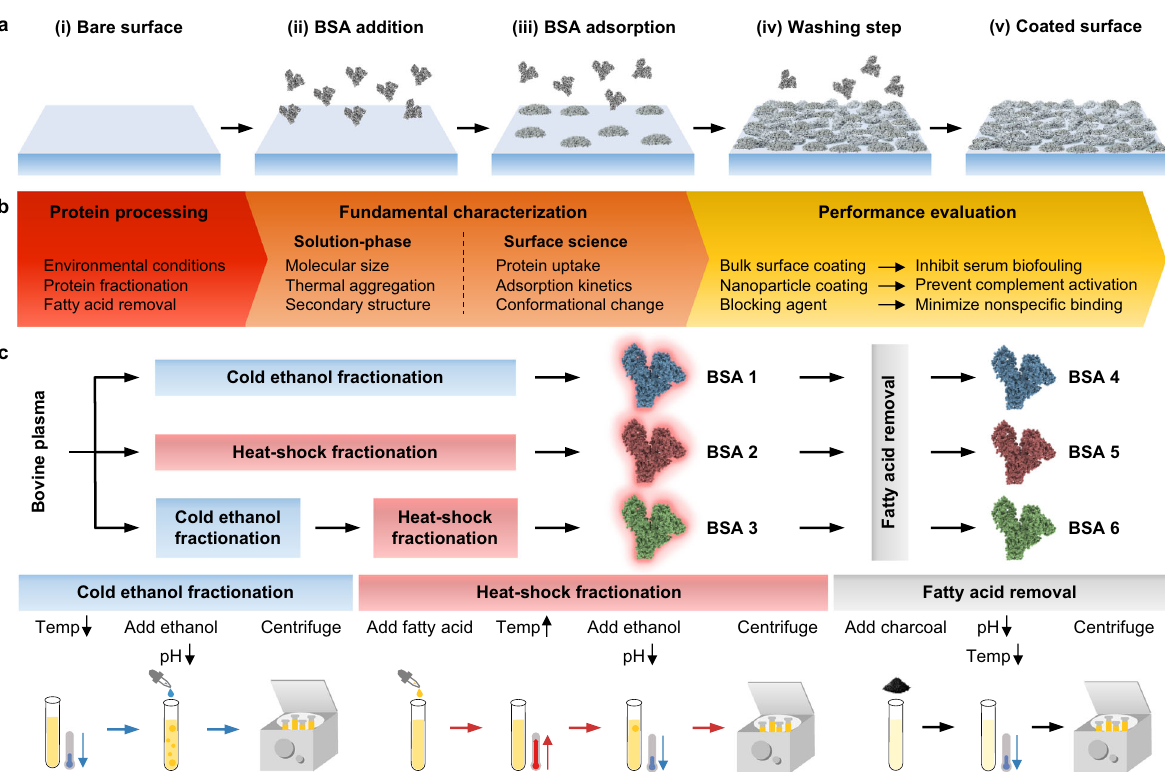
Fig. 1 Evaluation of BSA proteins to fabricate antifouling coatings. a Overview of basic steps in BSA coating protocols. (i) A target surface is identi fi ed to coat with BSA for surface passivation. (ii) BSA proteins in aqueous solution are incubated with the target surface. (iii) BSA proteins adsorb and denature on the target surface. (iv) A washing step is performed to remove weakly bound BSA protein molecules. (v) A fi rmly attached monolayer of adsorbed BSA protein molecules is formed on the surface. b Overall experimental strategy to analyze fabrication of BSA-based ultrathin fi lm coatings in terms of solution- phase protein structure and adsorbed protein layer properties. c Outline of puri fi cation routes to isolate BSA protein molecules from bovine plasma. Fatty acid-containing BSA proteins are designated as BSA 1, 2, or 3 depending on the puri fi cation method. Fatty acid-free versions of BSA 1, 2, and 3 were also prepared and are designated as BSA 4, 5, and 6,